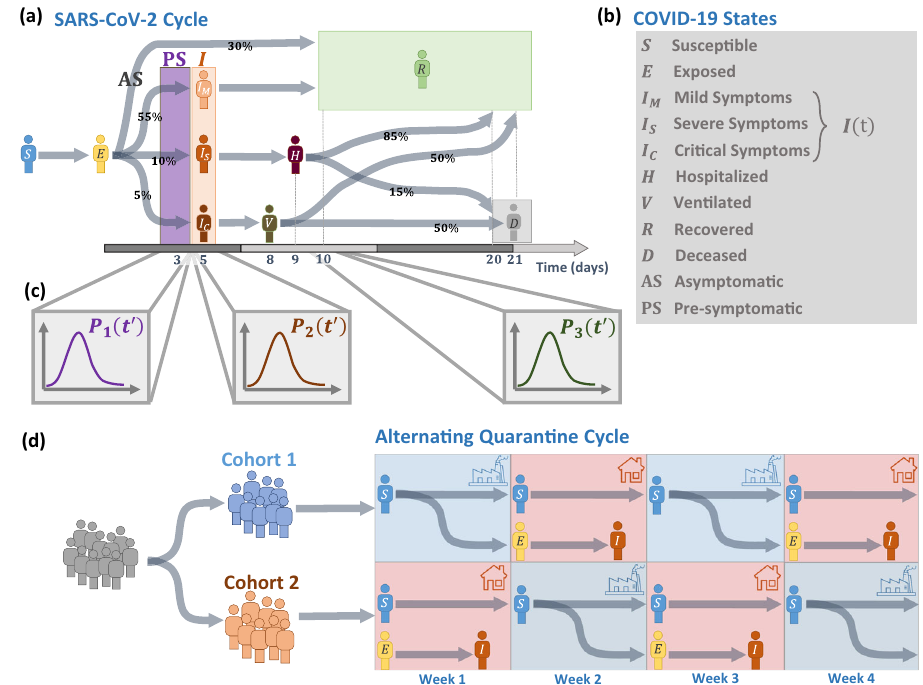
Fig. 1 The cycles of SARS-CoV-2 and COVID-19 vs. those of the alternating quarantine strategy. a We collected data on the transitions between the SARS-CoV-2 and COVID-19 states and constructed the characteristic disease cycle. Upon exposure ( E ) individuals enter an average 5 day incubation period prior to developing symptoms — mild ( I M at a rate of 55%), severe ( I S , 10%), or critical ( I C , 5%). The remaining ~30% are asymptomatic (AS). Infectiousness begins typically 3 days after exposure for symptomatic carriers, and 4 days for the asymptomatic (AS). The infection window (violet) captures the invisible presymptomatic (PS) spreading phase, in which individuals are infectious, but lack symptoms. Upon the onset of symptoms, infected individuals are isolated and cease to infect others. Consequently, asymptomatic individuals have a longer infection window, which extends until their transition to R . As the disease progresses a fraction of the infected population may require hospitalization ( H ) or ventilation ( V ), leading, to some probability of mortality ( D ). b The compartments of the COVID-19 cycle. We denote by I ( t ) the unity of all symptomatic individuals ( I = I M + I S + I C ). This corresponds to the diagnosed case count in each country (Fig. 3), which covers mainly the patients who exhibit symptoms. c While the illustrated cycle in ( a ) captures the average transition times between all states, in reality, some level of variability exists across the population. This is captured by the distribution P i ð t 0 Þ . For example, the individual transition time from E to PS, whose average is 3 days, is extracted from P 1 ð t 0 Þ (purple). d Alternating quarantine (AQ) splits the population into separate cohorts that alternate between periods of activity (going to work, blue) and inactivity (staying at home, red). Following their active week, (week 1) individuals in Cohort 1 may become exposed (yellow), in which case they will sit out their suspected pre- symptomatic period at home (week 2). By the end of their quarantine week, they will likely develop symptoms (orange) and remain in isolation until their full recovery. Those who did not develop symptoms during their week of quarantine are most likely uninfected (blue) and can resume activity in their upcoming active shift (week 3). Therefore the AQ cycle behaves as an effective ratchet, consistently quarantining the invisible spreaders, and hence, removing, with each weekly succession, infectious individuals from the active